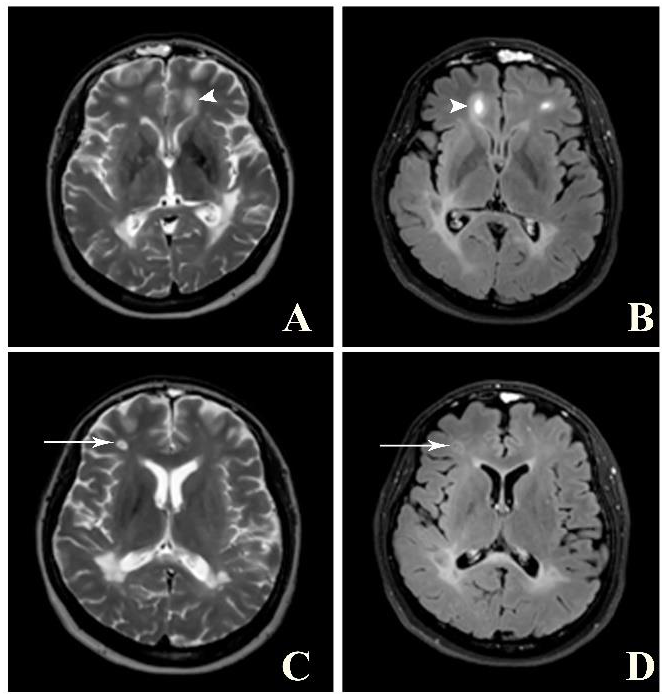
Figure 4. Balo’s concentric sclerosis. A and B : Axial T2W ( A ) and post-contrast FLAIR ( B ) images show a few lesions with alternating band of high and low signal intensity at bilateral frontal lobes (arrowhead). C and D : Axial T2W ( C ) and post-contrast FLAIR ( D ) images of the same patient show faint central and peripheral enhancement at the right frontal lobe lesion (arrow).